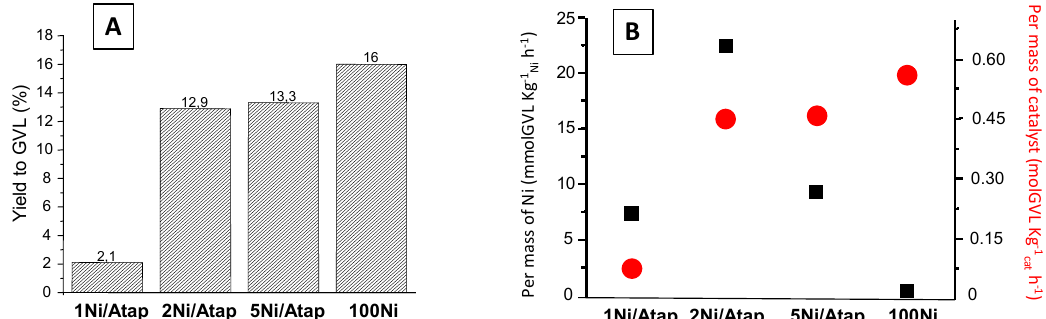
Figure 5. Influence on the Ni-loading in Ni/attapulgite catalysts ( A ) on the conversion of LA into GVL and ( B ) on the GVL productivity per mass of catalyst ( ● ) or per mass of Ni ( ■ ). Reaction conditions: T = 180 °C, 3.5 mL of water, 1.24 mmol of LA and 175 mg of catalyst.